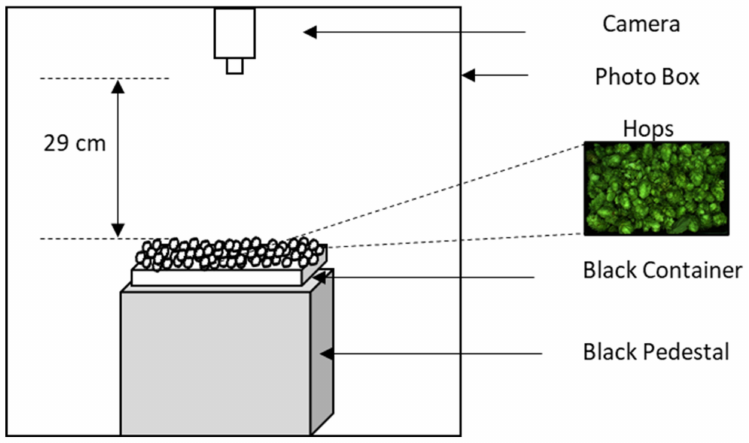
Figure 3. Schematic of RGB camera imaging system for